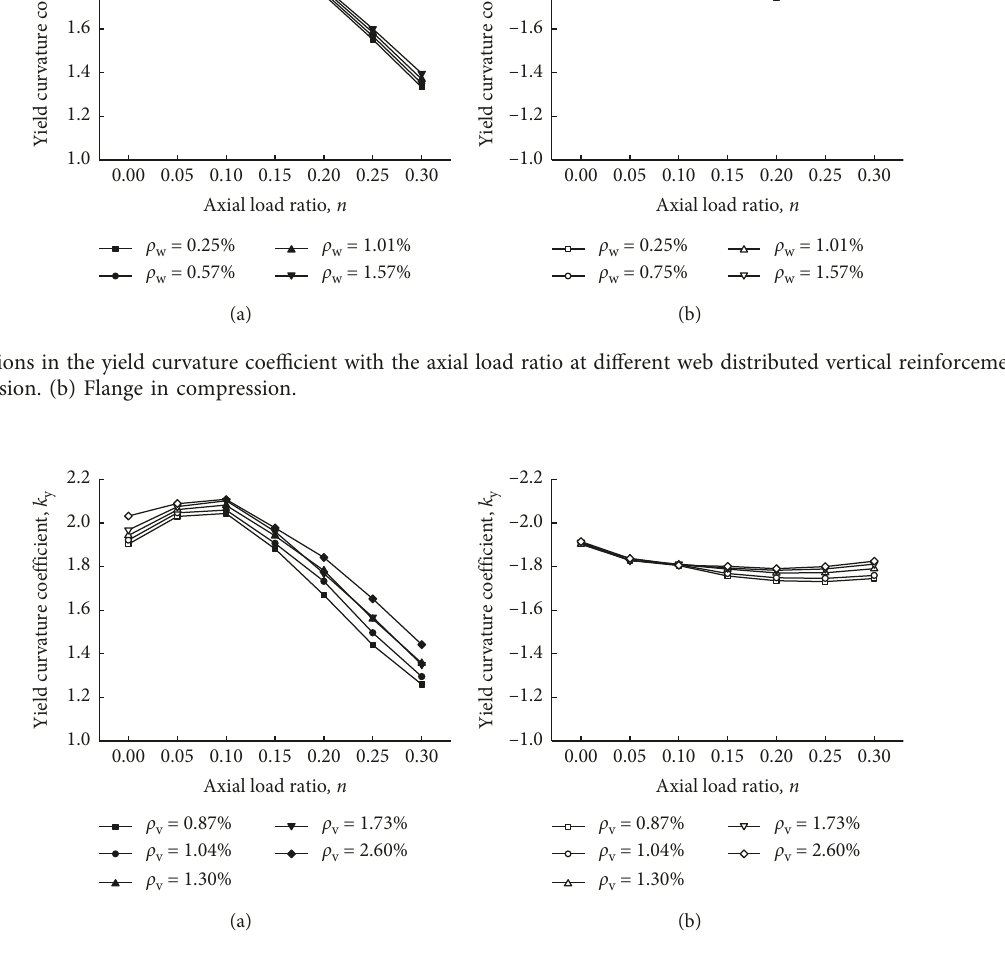
Figure 8: Variations in the yield curvature coefficient with the axial load ratio at different transverse reinforcement ratios. (a) Flange in tension. (b) Flange in